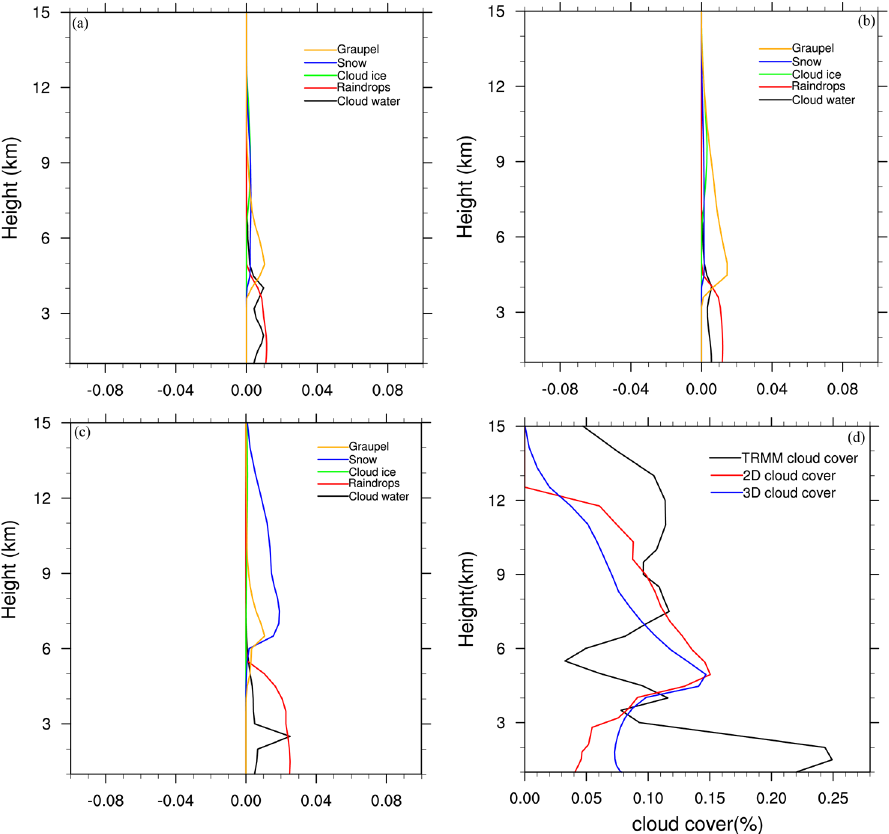
Figure 2. Domain mean profiles of the cloud water content, rain content, cloud ice content, snow content, and graupel content based on ( a ) the 2D and ( b ) 3D CRM simulations, ( c ) TRMM data, and ( d ) cloud cover for the 2D and 3D CRM simulations, as well as for the TRMM data. The domain ranges from 7 − 11°N and 165 − 169°E. Unit: g·m − 3 .